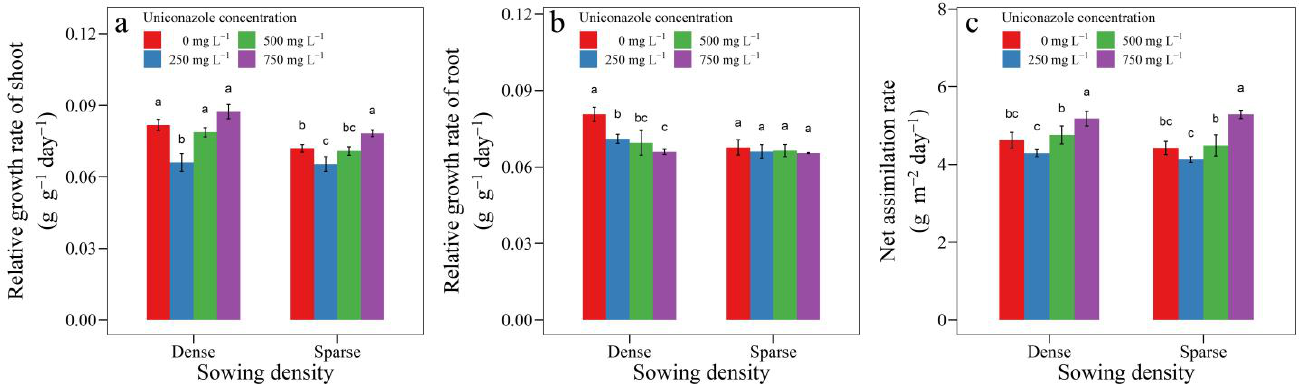
Figure 7. Growth indicators of seedlings at the 30th day after transplant from two densities with different uniconazole treatments. Values represent the relative growth rate of shoot ( a ), the relative growth rate of root ( b ), and the net assimilation rate ( c ). Sparse and dense represent sowing densities of 400 and 800 seeds per tray, respectively. Significant effects ( p ≤ 0.05) are shown by different letters in the same sowing density at 30 d. Table 4. Effects of uniconazole on yield and yield components of rapeseed in two sowing densities.